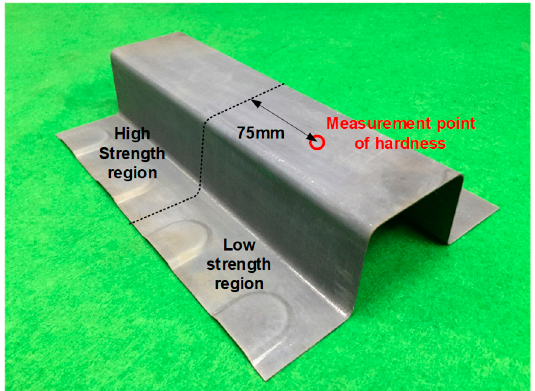
Metals 2019 , 9 , x FOR PEER REVIEW Figure 10. Measurement point of hardness for partially quenched part. Figure 10. Measurement point of hardness for partially quenched part.